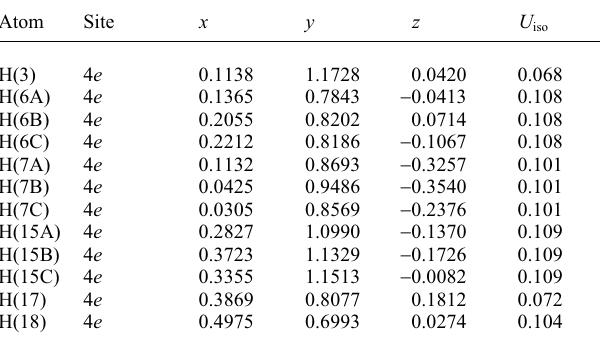
Table 2. Atomic coordinates and displacement parameters (in Å 2 ) .